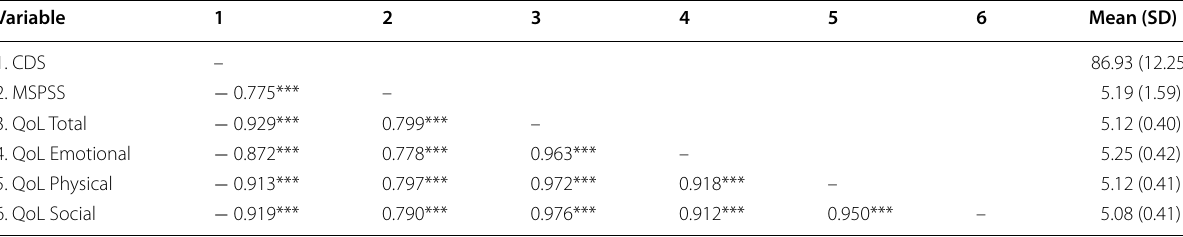
CDS Cardiac Depression Rating Scale, MSPSS Multidimensional Scale of Perceived Social Support, QoL quality of life. *** p < 0.001